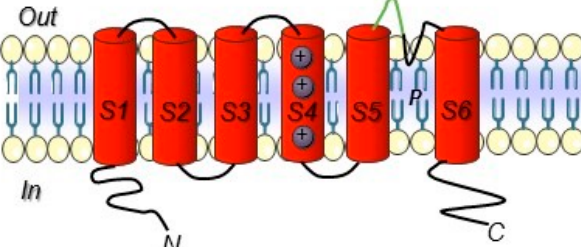
Figure 3. Voltage-gated K + ion channel topology. The six transmembrane segments S1–S6 are reported. The S5 and S6 domain are connected with a loop that control selectivity. In green, the loop portion towards which the hERG1-mAb was developed is highlighted (see the following paragraphs). Both the N- and C- terminus are intracellular.